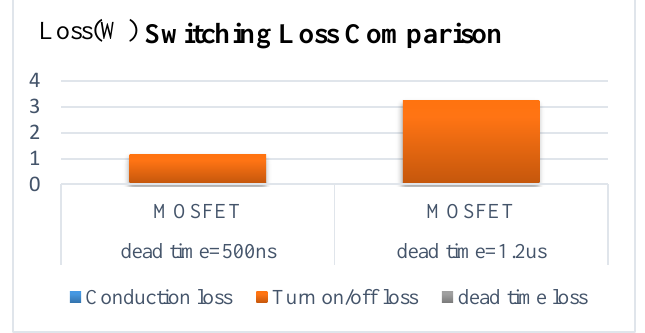
Figure 8. Switching loss comparison.